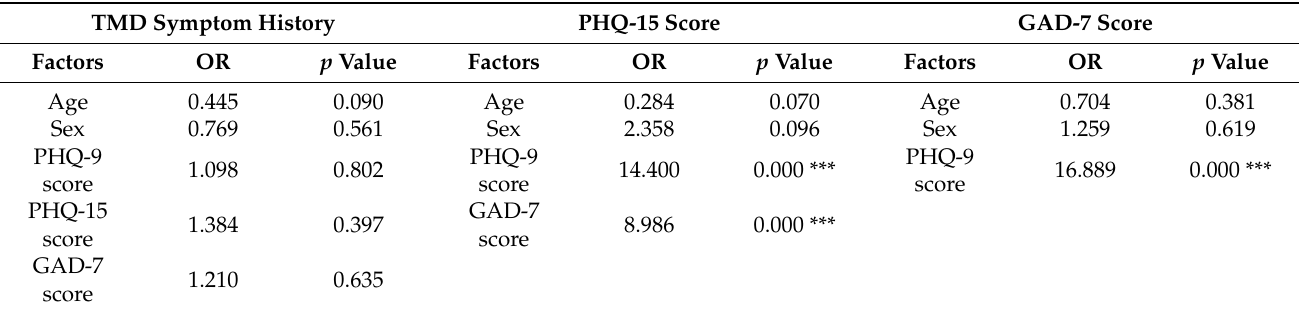
Table 7. Univariate logistic regression analysis for estimating potential confounding